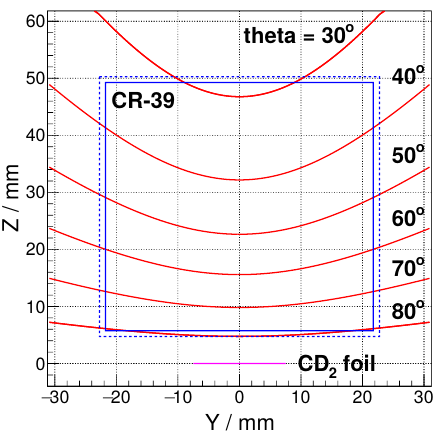
Figure 9. Acceptance for α particles on the left or right side of the polarimeter. The Z axis represents the beam direction, and the CD 2 foil-target is located at Z = 0. The margin cut is shown by the solid square while the dashed square indicates the location of the scanning frame (see text). The hit positions for various polar angles are also